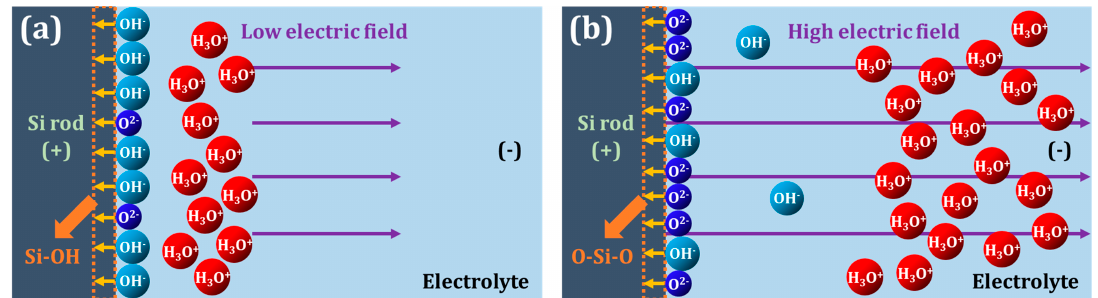
Figure 4. Illustrations of how oxygen content is affected by the anodization voltage (( a ) low voltage and ( b ) high voltage).